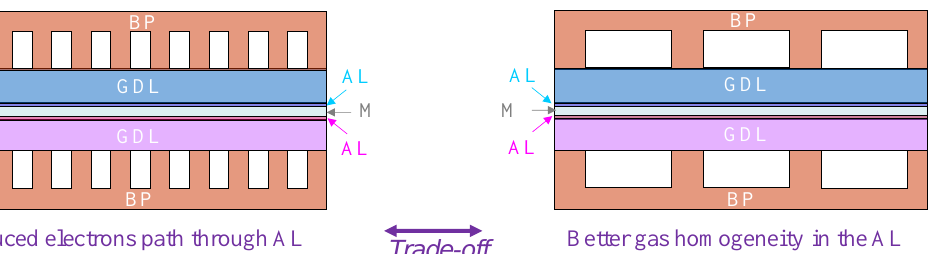
Figure 13. Trade-o ff in designing BP channels. Figure 13. Trade-off in designing BP channels.